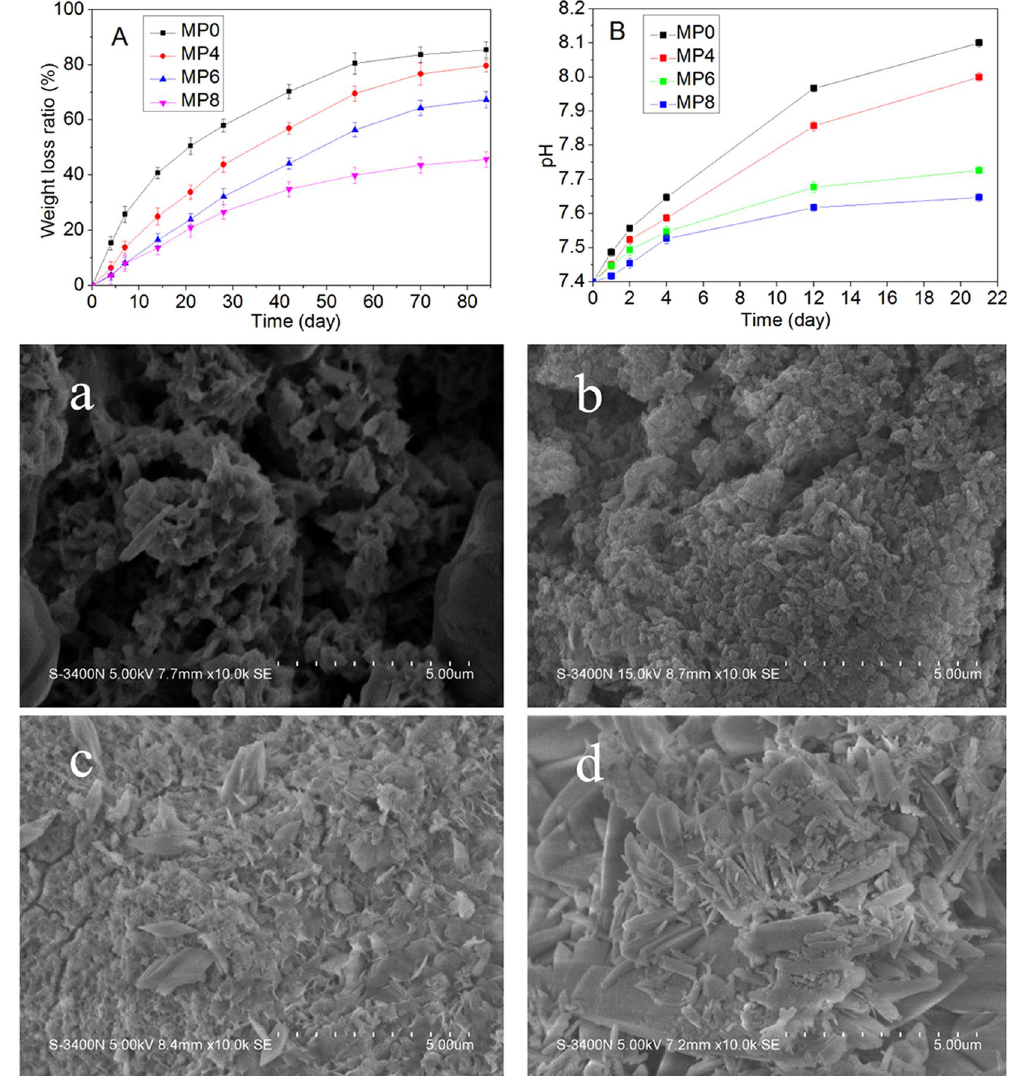
Figure 3. Weight loss ( A ) and pH change in the solutions ( B ) after MP0, MP4, MP6 and MP8 were immersed in a PBS solution for different time periods. In addition, the SEM images show the surface morphology after MP0 ( a ), MP4 ( b ), MP6 ( c ) and MP8 ( d ) were soaked in a PBS solution for 3